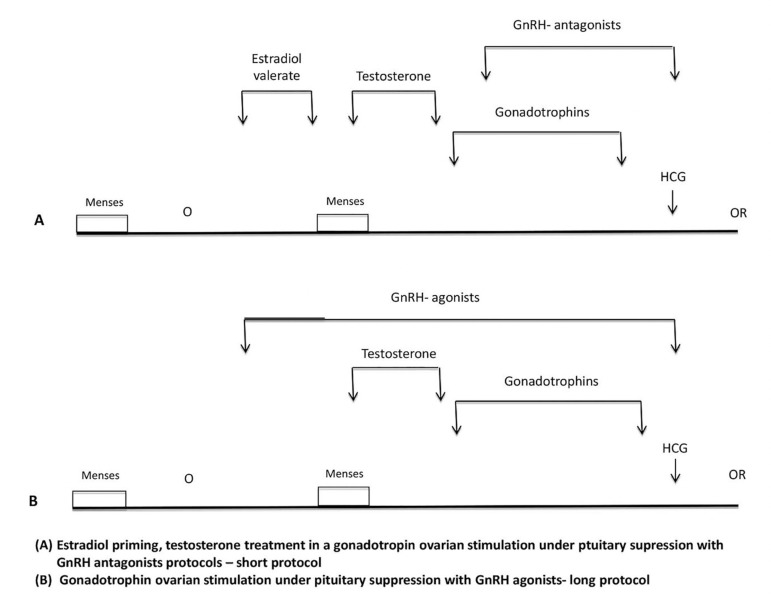
Schematic representation protocols.